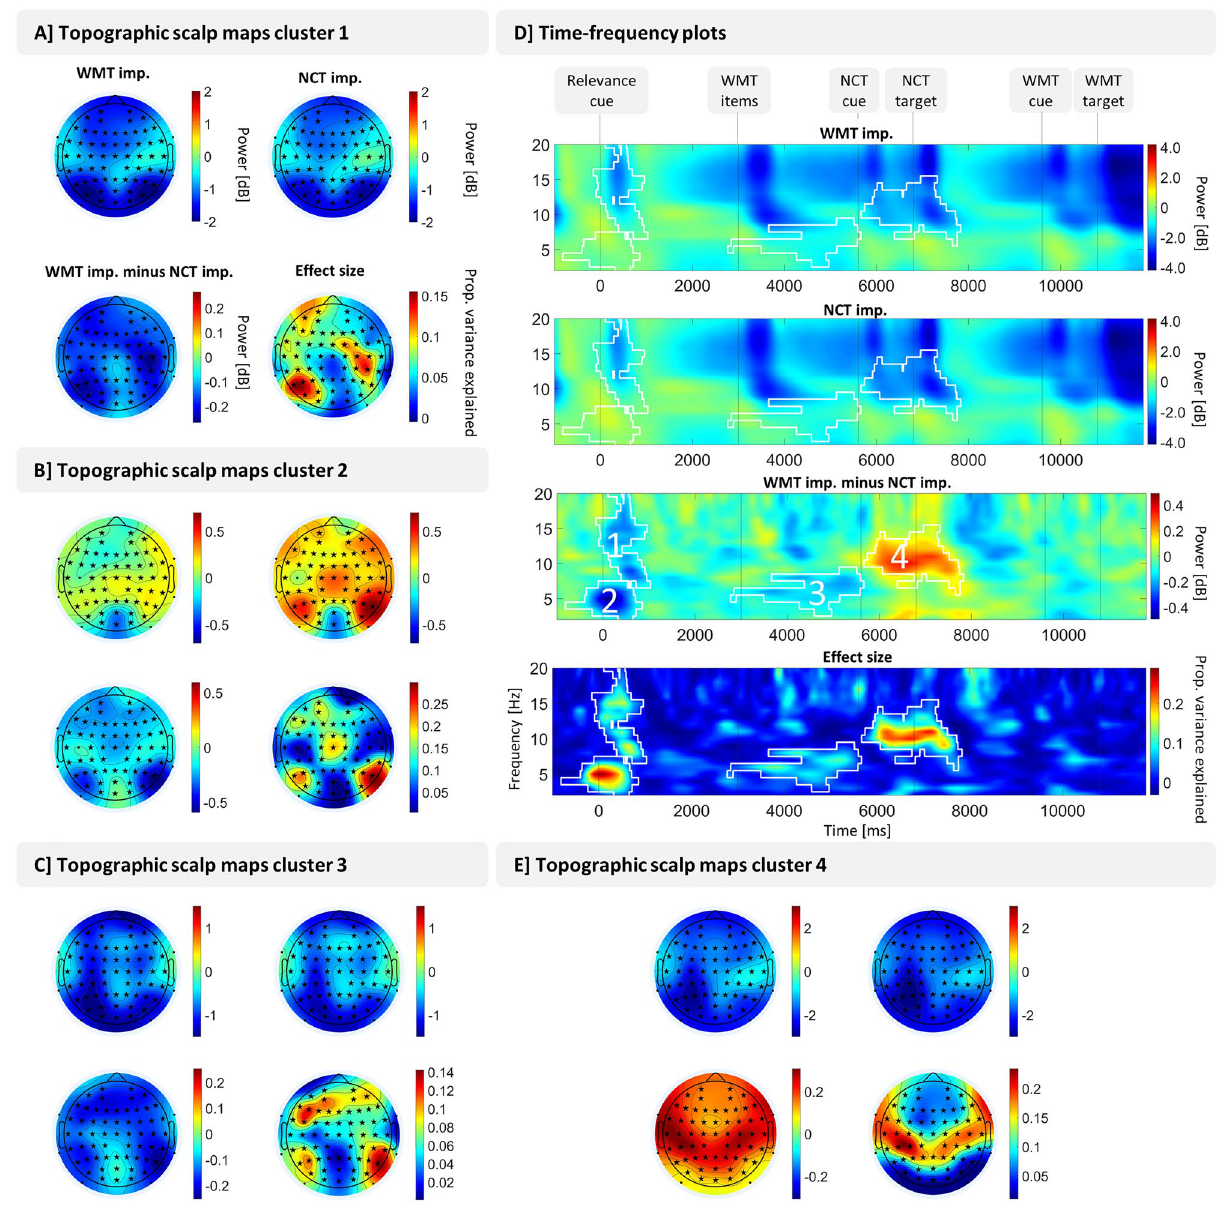
Figure 2. Result of univariate power analysis. A cluster-based permutation test in the electrode × time × frequency space comparing power in number classification task important (NCT imp.) trials and working memory task important (WMT imp.) trials revealed four significant clusters. Panel ( A ), ( B ), ( C ) and ( E ) show topographic scalp maps averaged over significant time–frequency points of the respective cluster. Significant channels are marked with a black asterisk, not significant channels with a black dot. Panel ( D ) shows time-frequency plots with power values averaged over all channels (as the four clusters were all significant at nearly all channels). Contour lines frame significant time–frequency points and the numbers label the clusters from 1 to 4. Effect sizes are adjusted partial eta squared. Power values are decibel-normalized with a condition- unspecific baseline ranging from 700 to 200 ms prior to the onset of the relevance